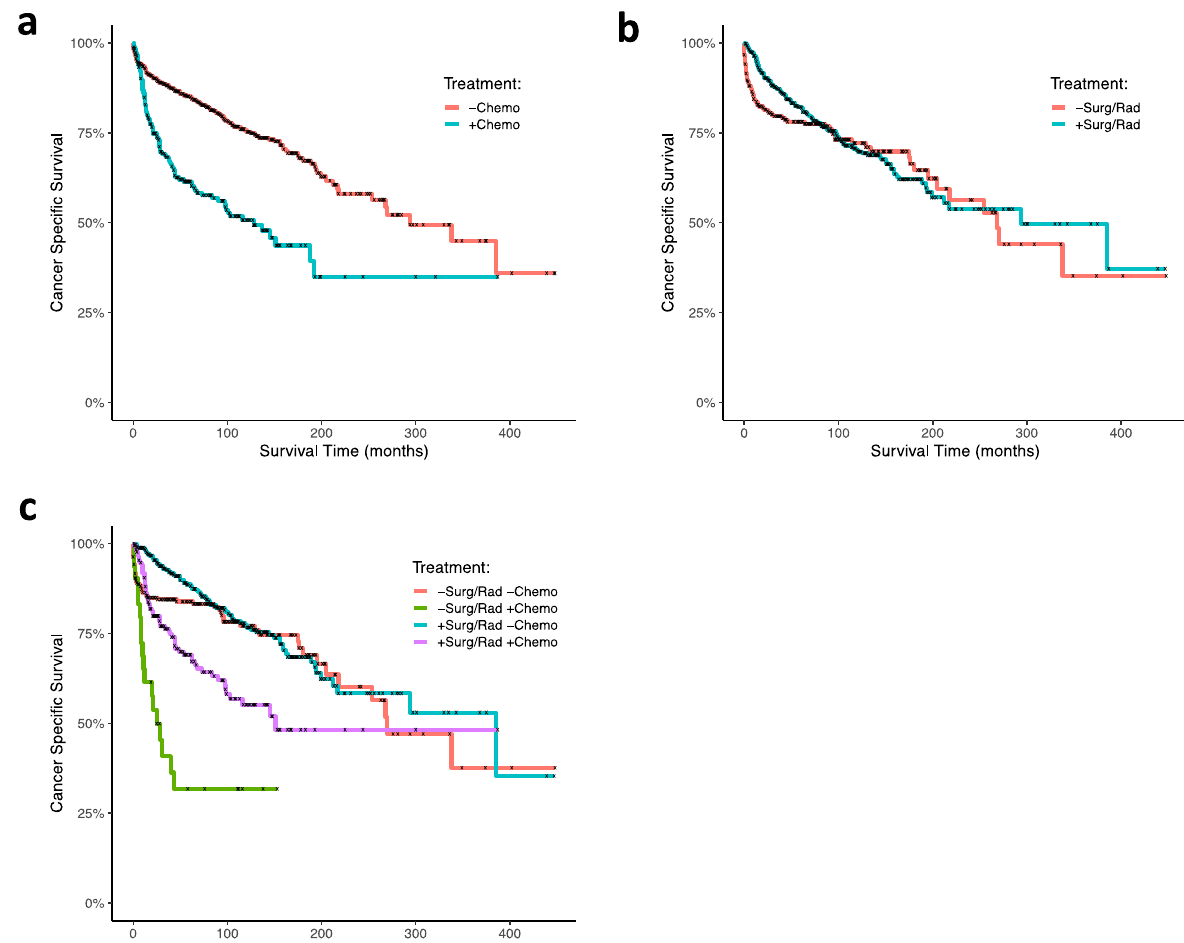
Figure 2. Kaplan–Meier curves of ONB patient cancer-specific survival within age at diagnoses. ( a ) Ages at diagnoses were stratified at 0–20 years, 21–40 years, 41–60 years, and greater than 60 years. ( b ) Survival curve comparing 0–20-year-old age group with patients greater then 20 years old at diagnosis.